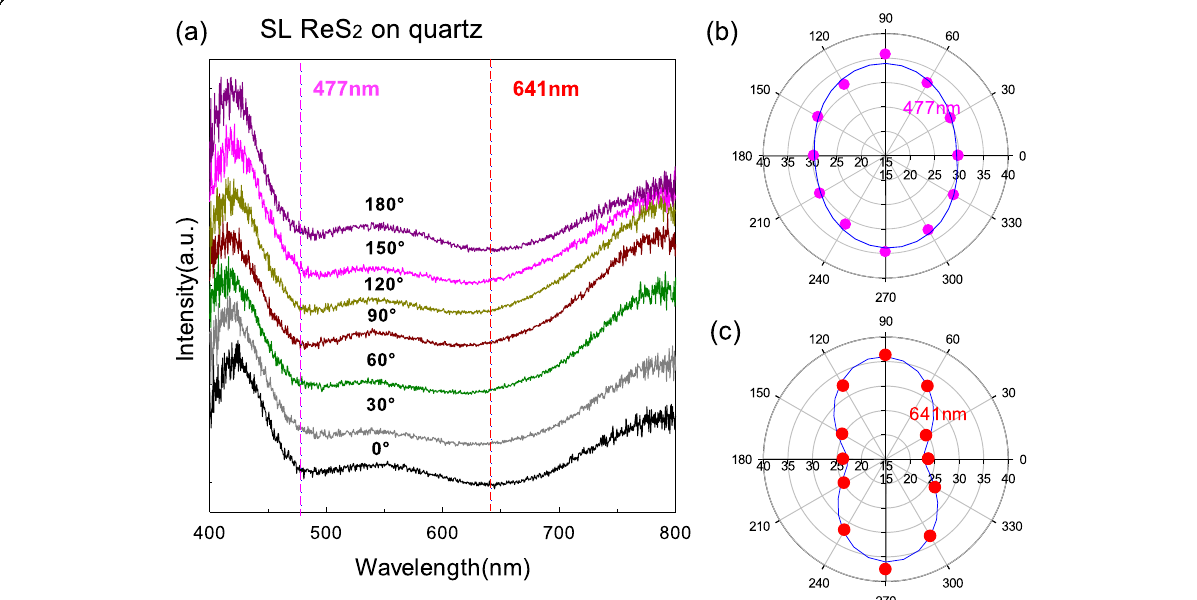
Fig. 4 a The polarization optical contrast curves of SL ReS 2 flakes supported on quartz substrate. b The intensity variation at ~ 477 nm from 0 to 360°. c The intensity variation at ~ 641 nm from 0 to